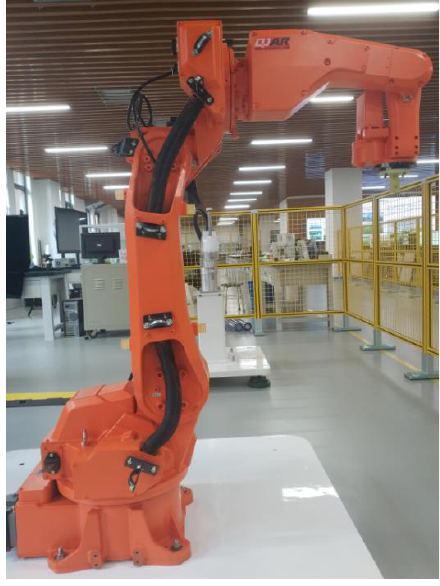
Figure 10. Industrial robot without simulation model. Divide the original signals into two groups, take 40,000 sampling points for each group of original signals, and calculate the time-domain signal characteristics of the two groups of signals. The results are shown in Figure 11.